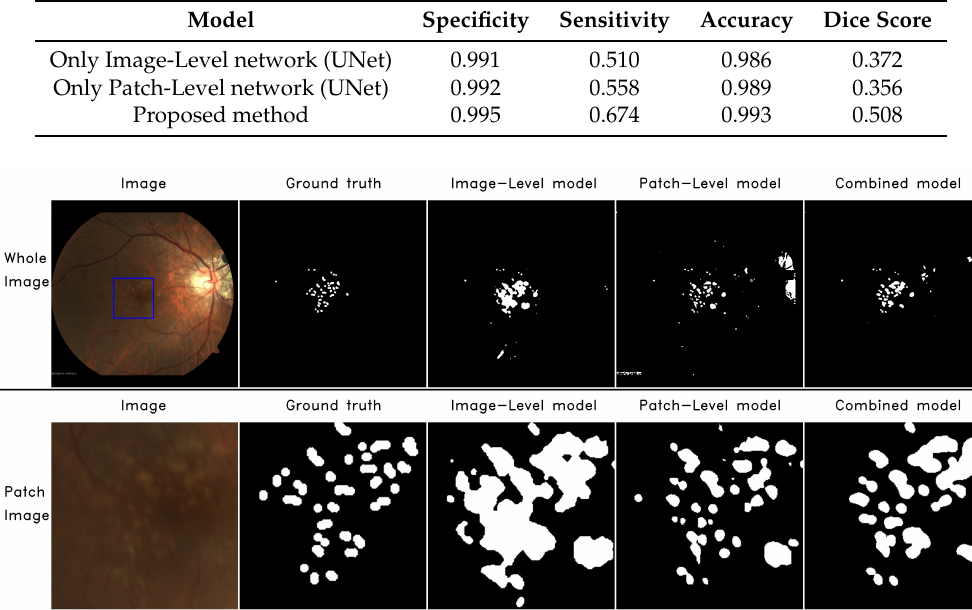
Table 1. The impact of global, local, and combination of both information for drusen segmentation. We evaluate on our dataset from Kangbuk Samsung Hospital.